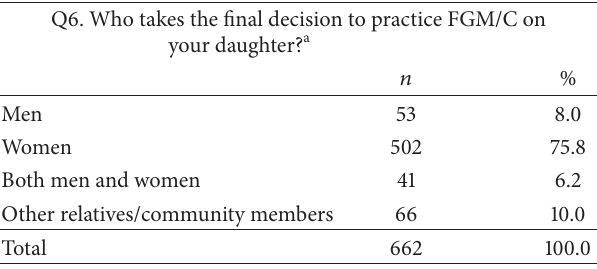
Table 4: Knowledge, attitudes, and practices.